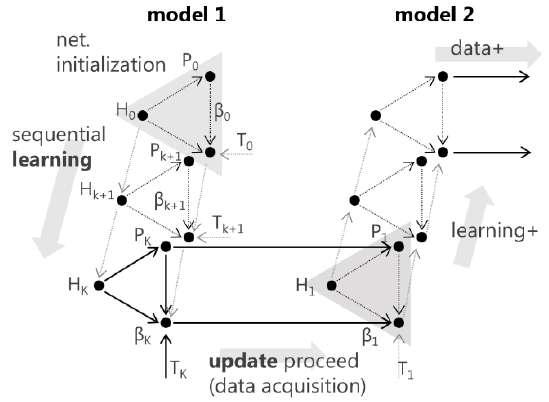
Figure 4. Learning process design for OS-ELM and its update procedure.